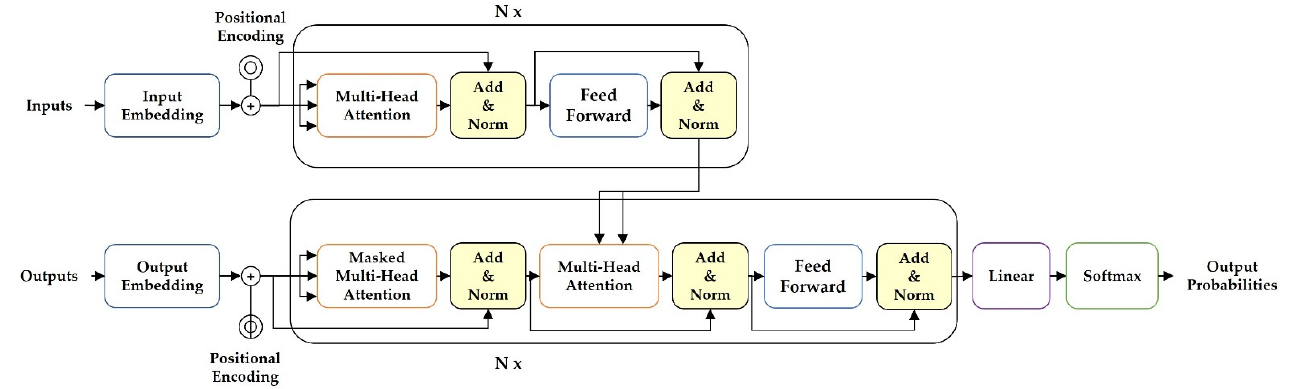
Figure 5. Structure of the transformer